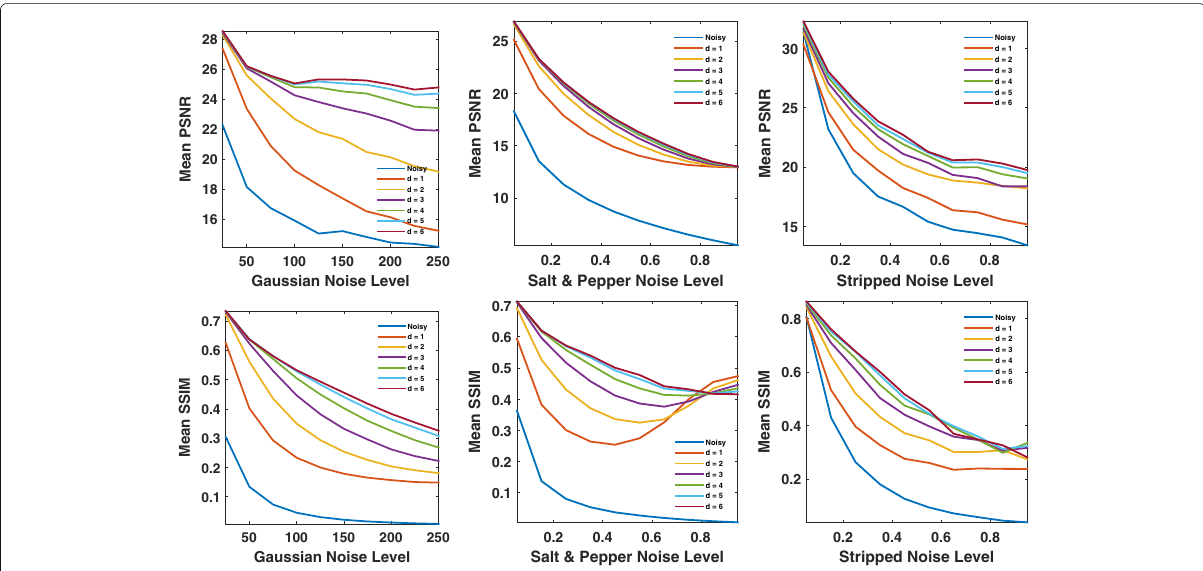
Fig. 11 Average denoised PSNR and SSIM for Gaussian, salt & pepper, and stripped noise for different radii d using six images